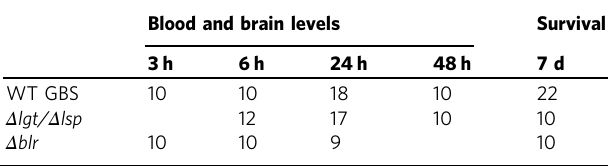
Table 2 Sample size per time point per bacterial strain.